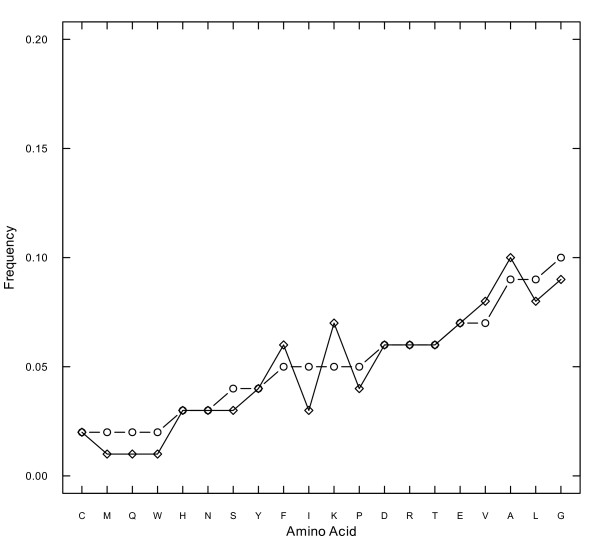
The amino acid composition of all inferred coevolving sites (marked with "rhombus"), as compared to all RBCL sequences (marked with "circle"). The amino acids are ordered according to their frequency in all RBCL sequences.